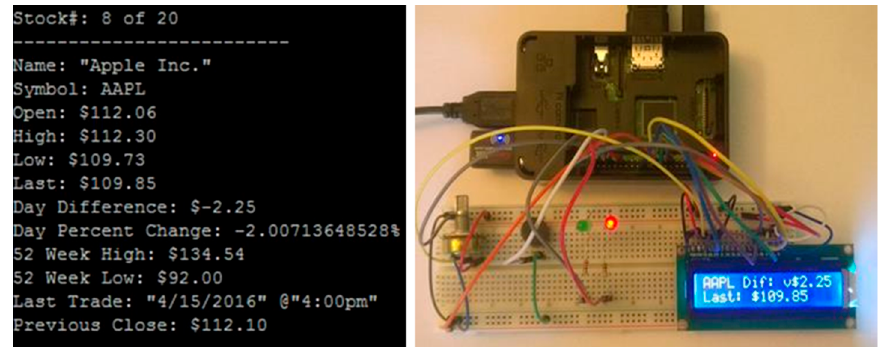
Figure 2. A prototype of the stock ticker system. The left side shows stock information in the terminal of Raspberry Pi. The right side shows the setup of the system: the stock information is displayed in the LCD, while the red LED indicates the price has dropped from the previous day’s closing price.